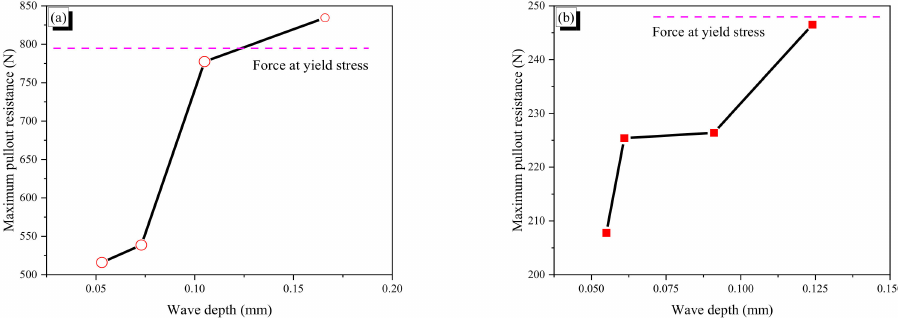
Figure 14. Maximum pullout resistance of the CR fibers: ( a ) CR1.0-N fibers; ( b ) CR0.7-N